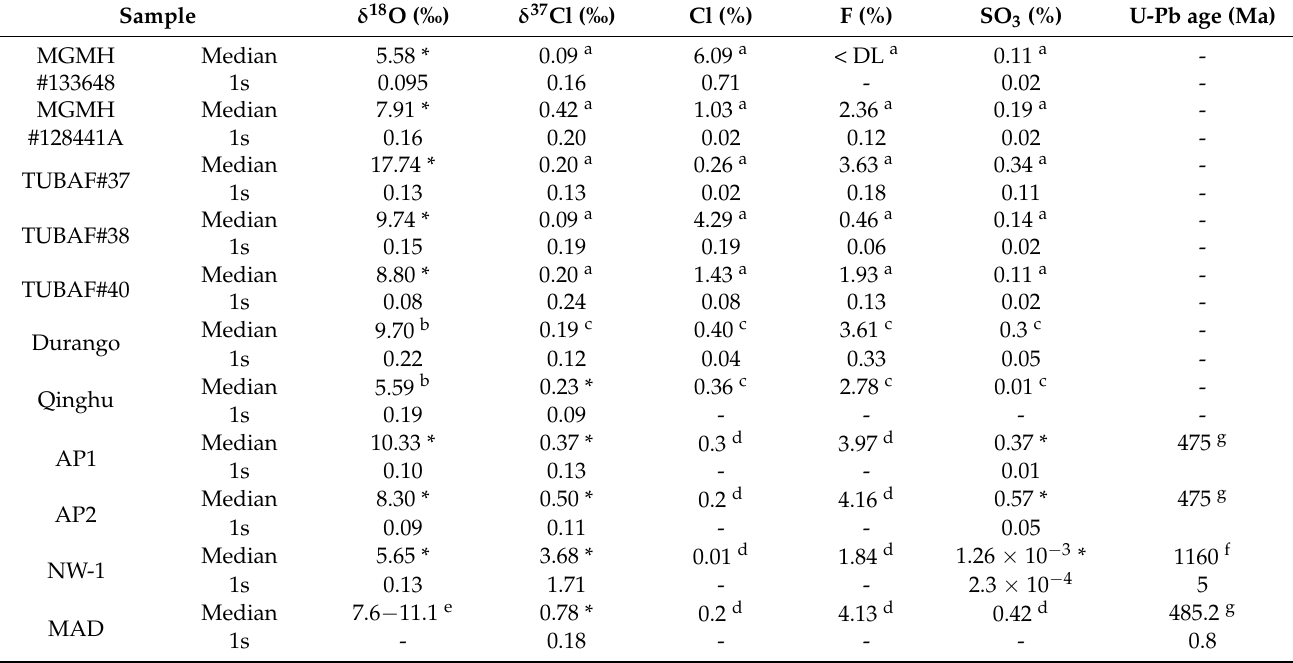
Table 6. Recommend isotopic values for 11 apatite